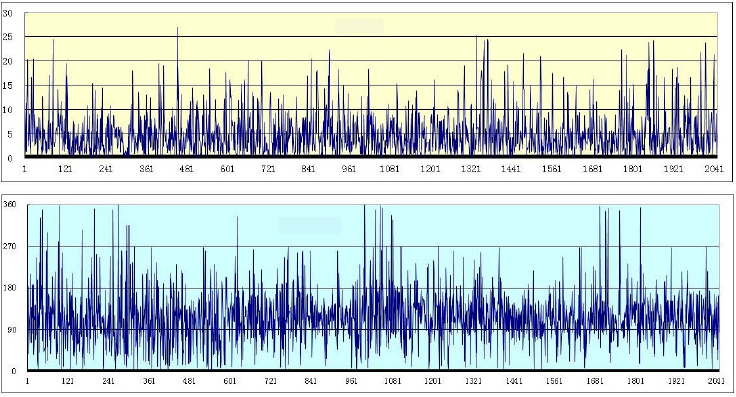
Figure 2. Measured well inclination and tool face angles of a well in western of Sichuan,